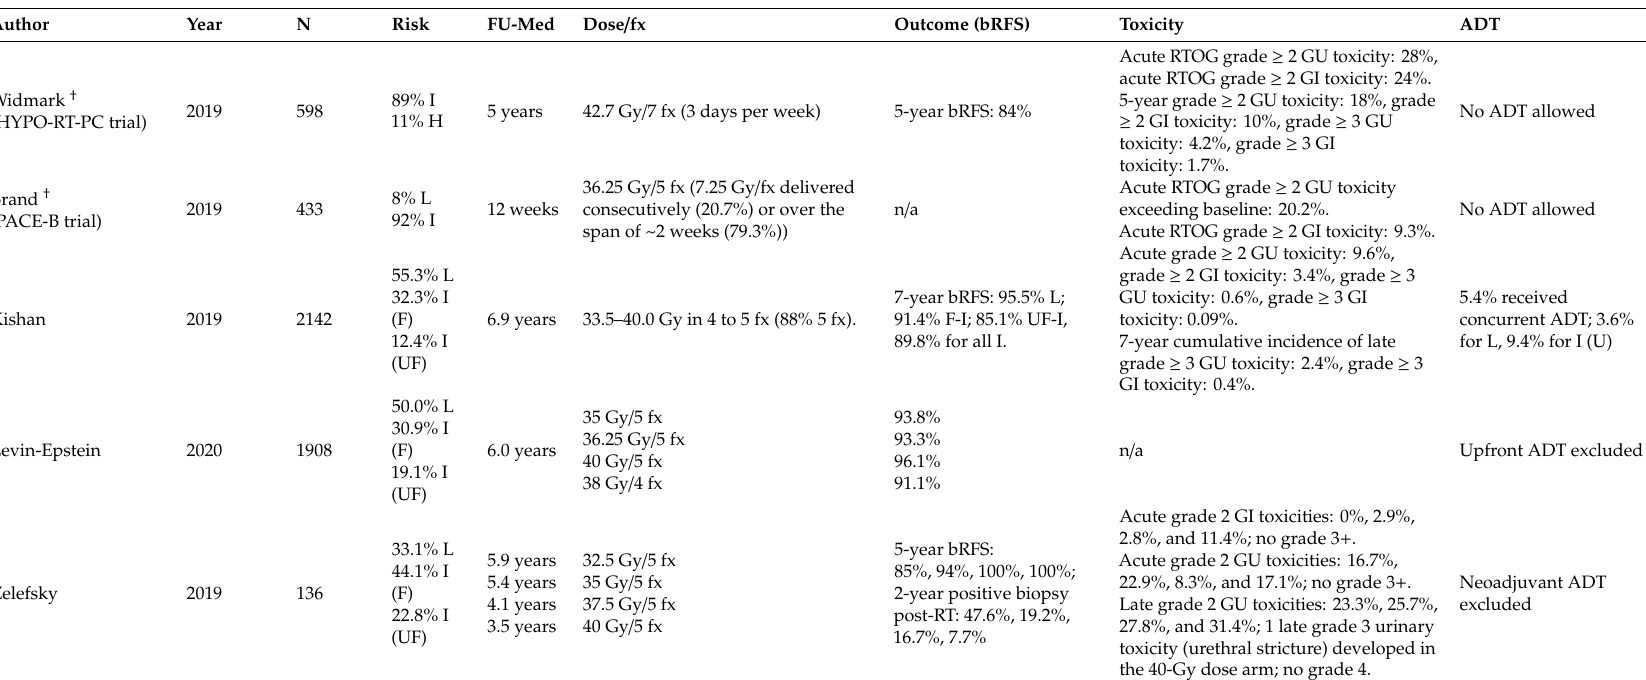
Table 1. Selected recent stereotactic body radiation therapy (SBRT) monotherapy series in low- and intermediate-risk